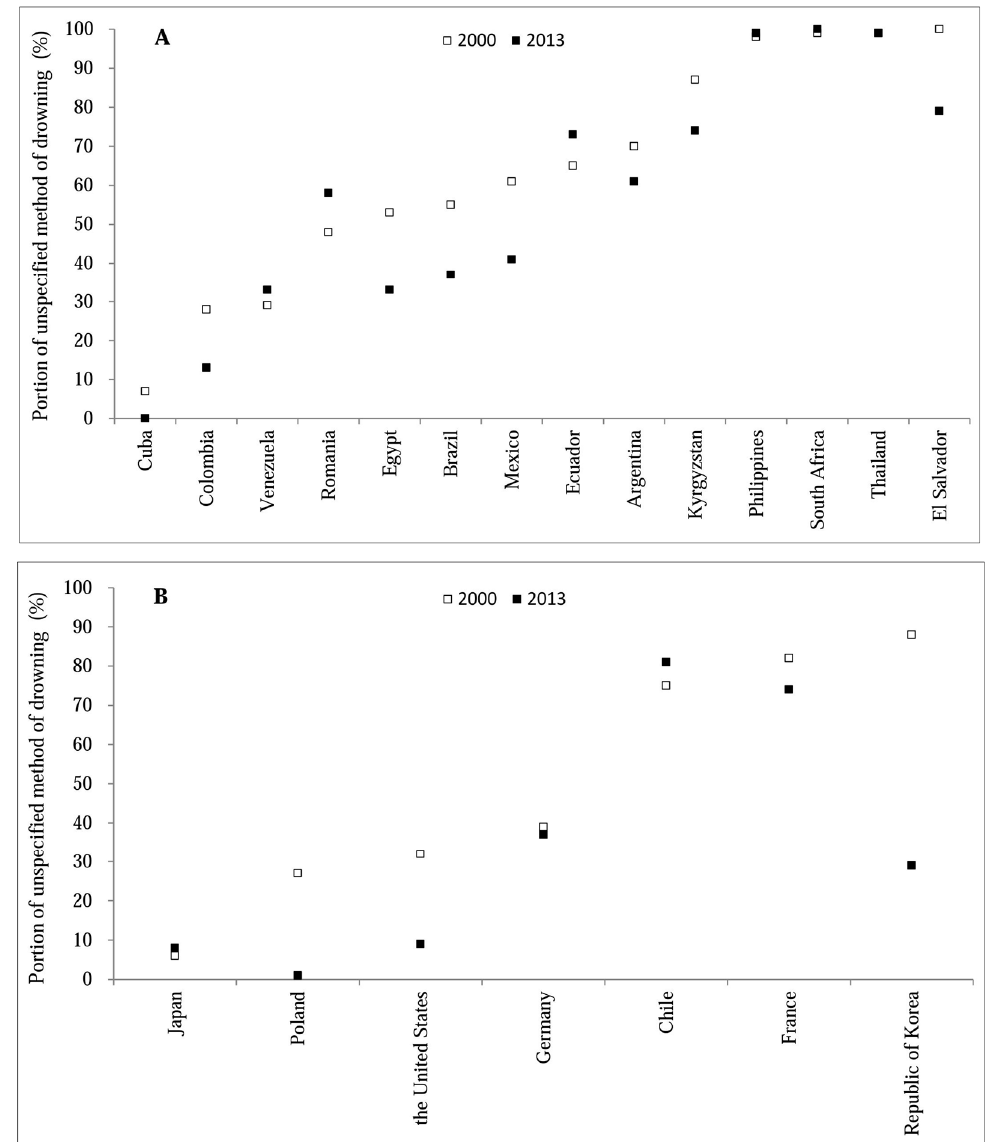
Figure 3. Portion of drowning with unspecified methods in 21 countries, 2000–2013: ( A ) Low- and middle-income countries; ( B ) High-income countries.